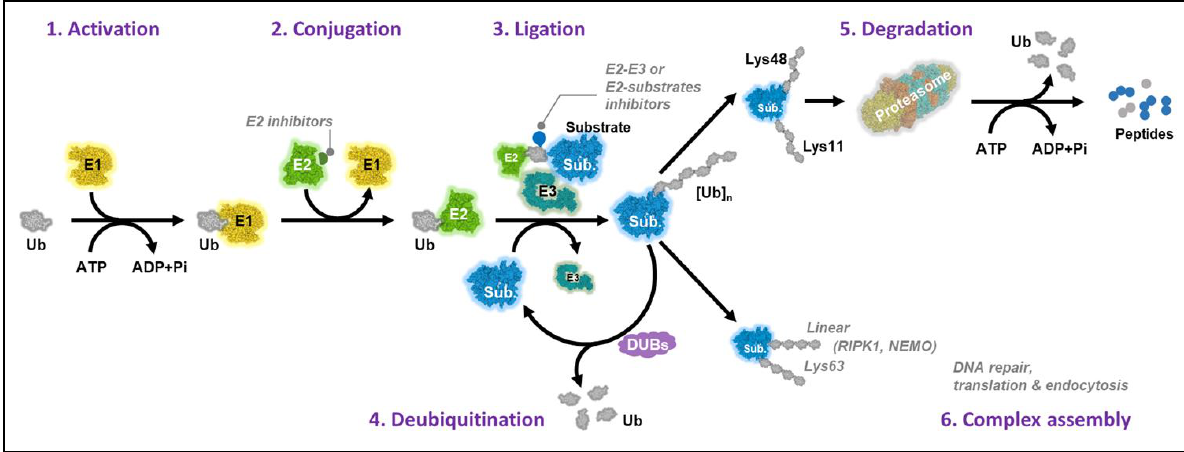
Figure 1. Ubiquitination cycle. (1) Activation: ubiquitin (Ub) is activated by the ubiquitin-activating enzyme (E1) in an ATP-dependent manner. (2) Conjugation: the ubiquitin-conjugating enzyme (E2) transfers the activated Ub to the ubiquitin-ligase enzyme (E3). (3) Ligation: an E3 ligase recruits a target protein and is responsible for transferring the ubiquitin to the target substrate. (4) Deubiquitination: ubiquitin moieties can be removed from substrate proteins by deubiquitinase enzymes (DUB) action. Depending on the outcome of protein ubiquitination, the fates of substrates will be different. (5) Canonical K48 linkage leads to recognition by the 20S proteasome, triggering degradation of the substrate, yielding small peptide fragments and free ubiquitin. (6) Non-canonical types can be formed. Shown here is a K63 linkage, which is not recognized by the proteasome, resulting in altered function of the substrate protein, such as DNA repair, translation, and endocytosis.